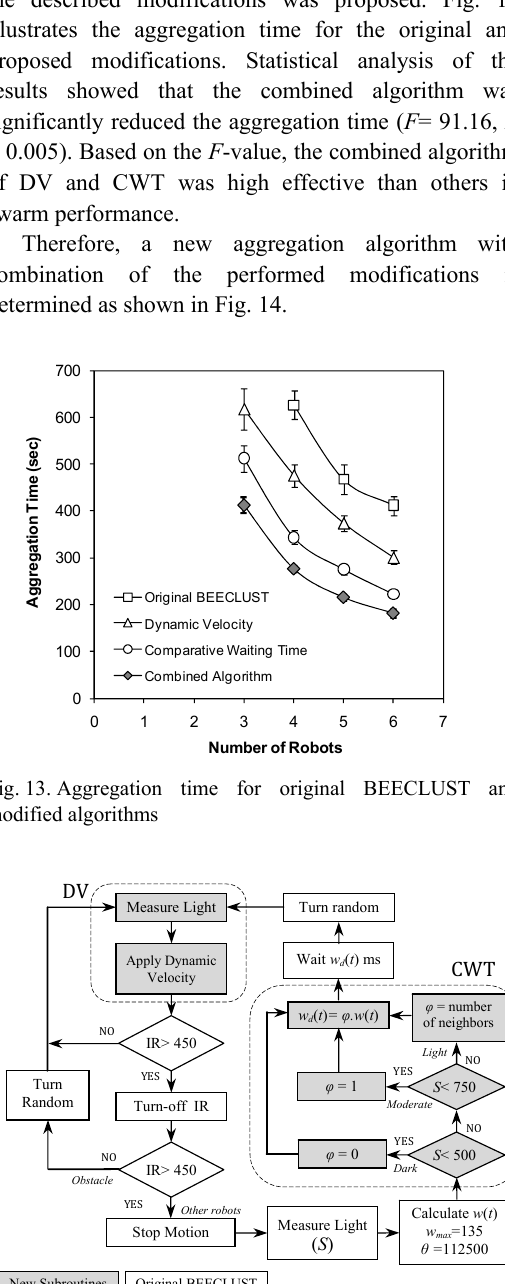
Fig. 12. Aggregation time and collision of each robot for BEECLUST and comparative waiting time